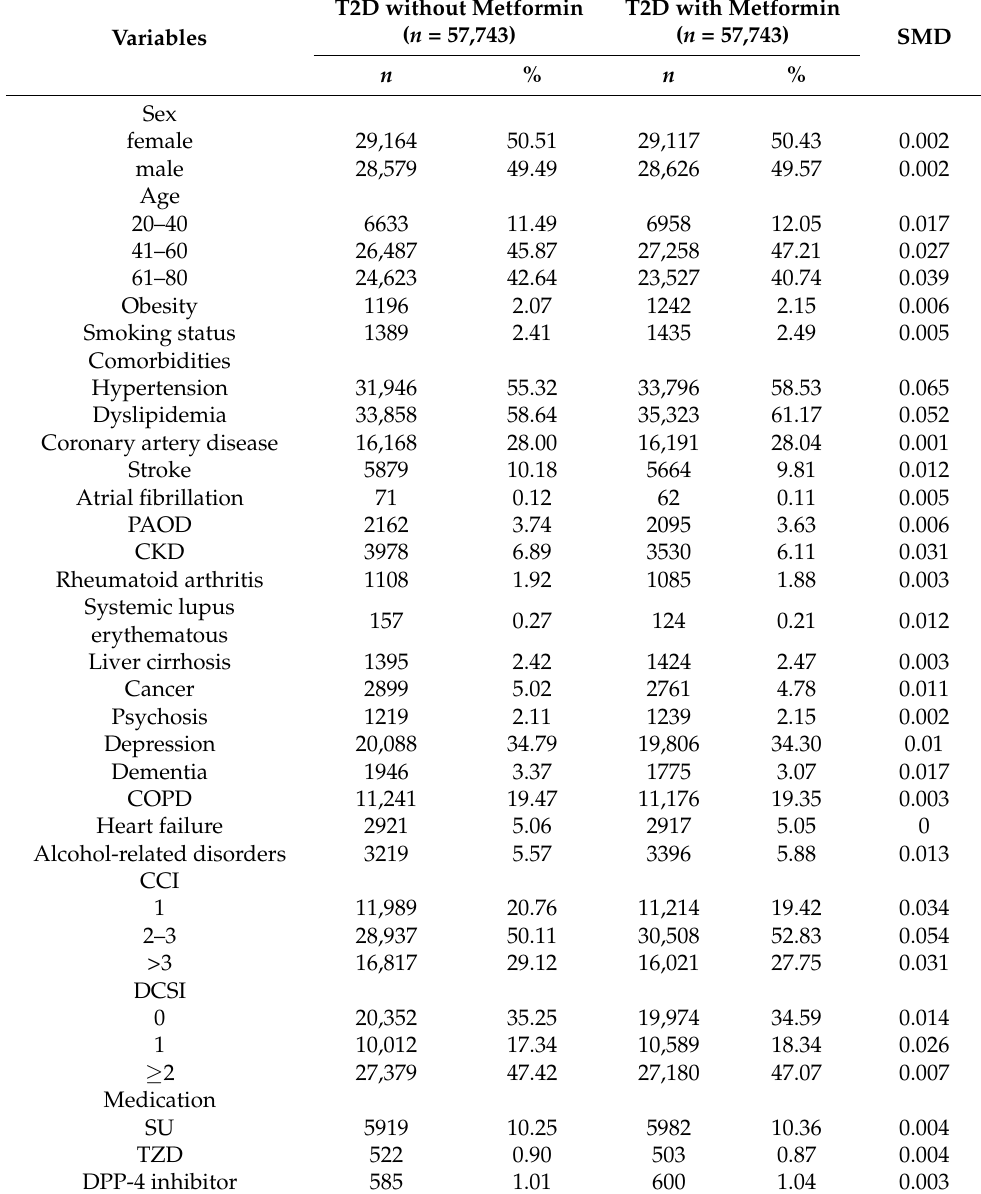
Table 1. Comparison of baseline characteristics in T2D without metformin and with metformin cohorts. T2D without Variables